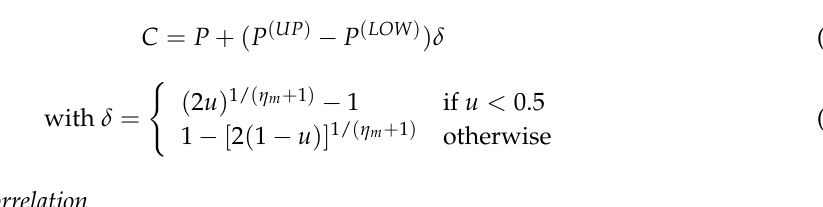
Figure 1. Template t can be contained in frame I in a rectangle of size m top left